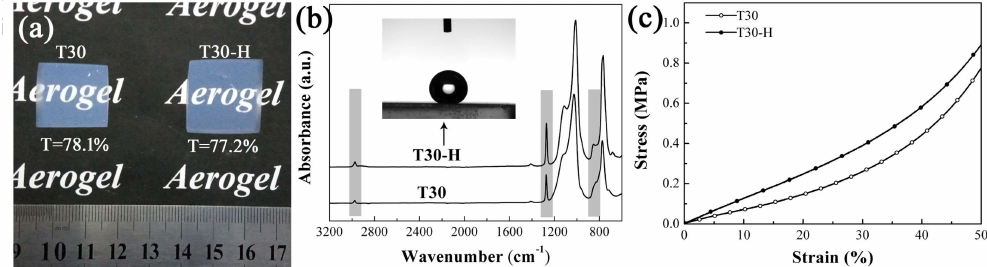
Figure 8. Photographs of the monolithic aerogels T30 and T30-H ( a ); FTIR-ATR spectra ( b ) and compressive stress versus strain curves of aerogels T30 and T30-H ( c